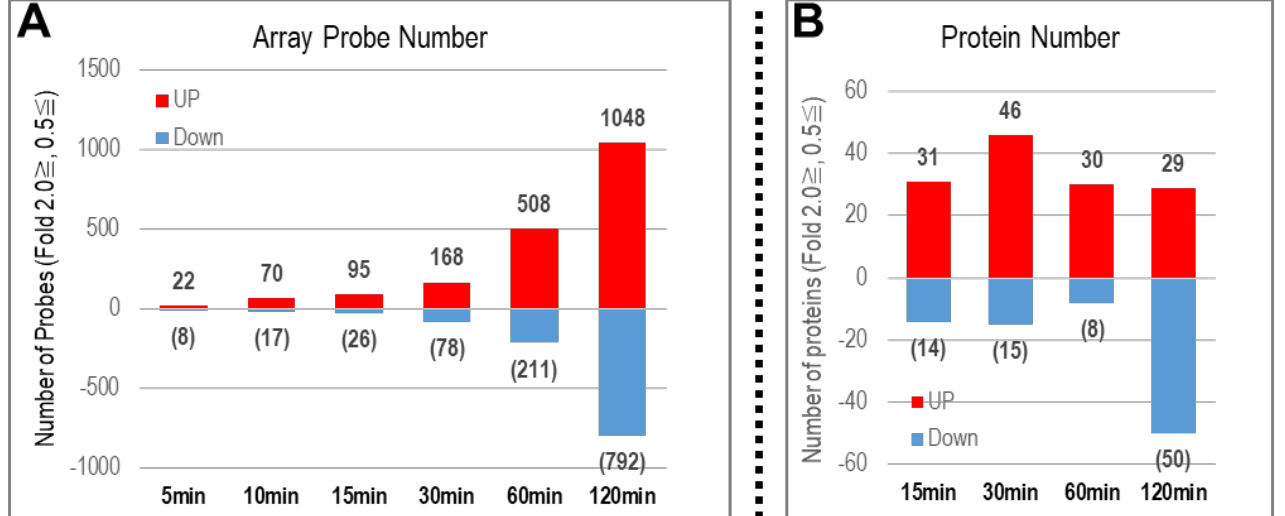
Figure 2. Number of genes ( A ) and proteins ( B ) whose expression was altered by PACAP in the PC12 cells. ( A ) Genes whose expression was altered by microarray analysis of PC12 cell RNA at 5, 10, 15, 30, 60, and 120 min after addition of PACAP. ( B ) Proteins with altered expression obtained by TMT-LC-MS/MS analysis of PC12 cell proteins at 15, 30, 60, and 120 min after addition of PACAP.